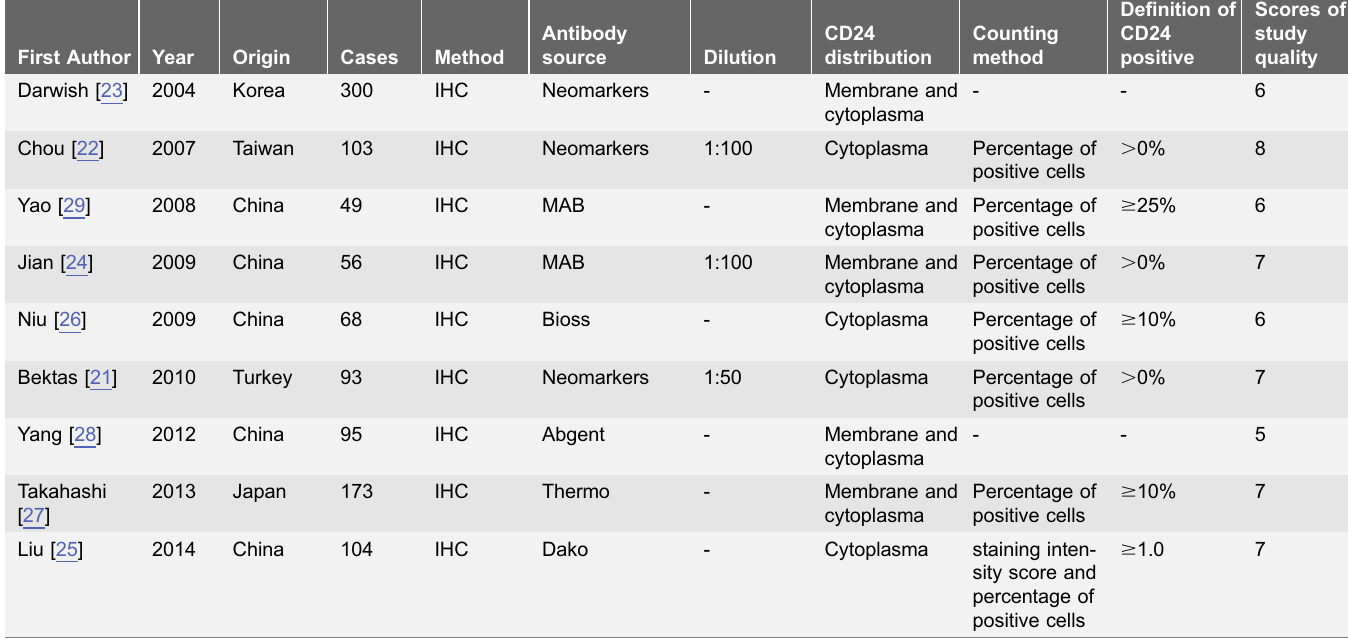
Table 1. Characteristics of eligible